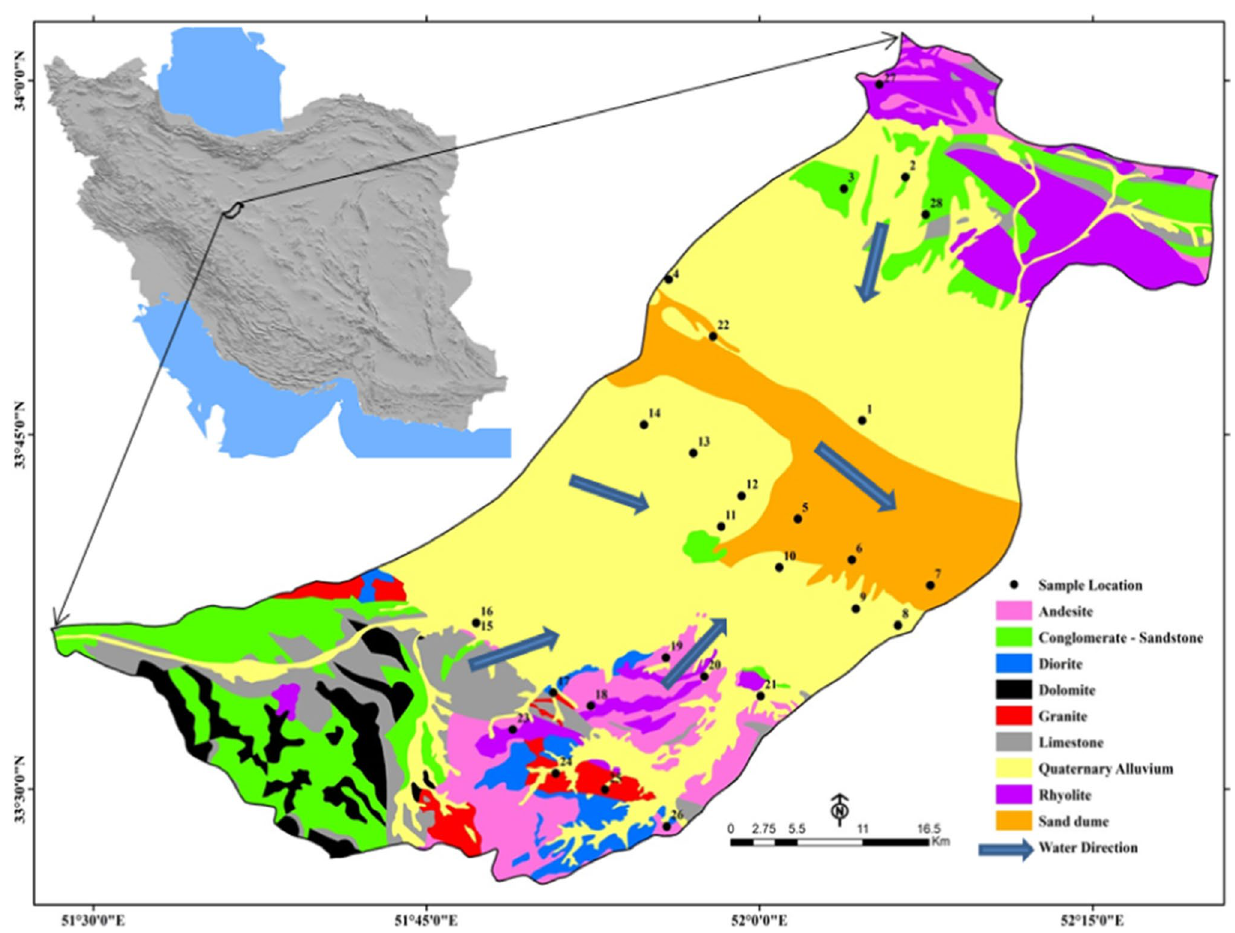
Fig. 1 Geologic map and sample location of the study